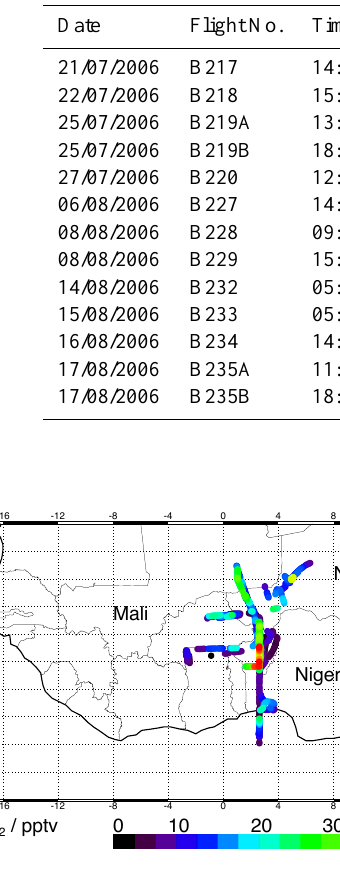
Fig. 8. Spatial distribution of HO 2 observed over West Africa during the African Monsoon Multidisciplinary Analyses (AMMA) campaign. Redder colours indicate the highest concentrations of HO 2 , which were observed over the forested regions of Benin.